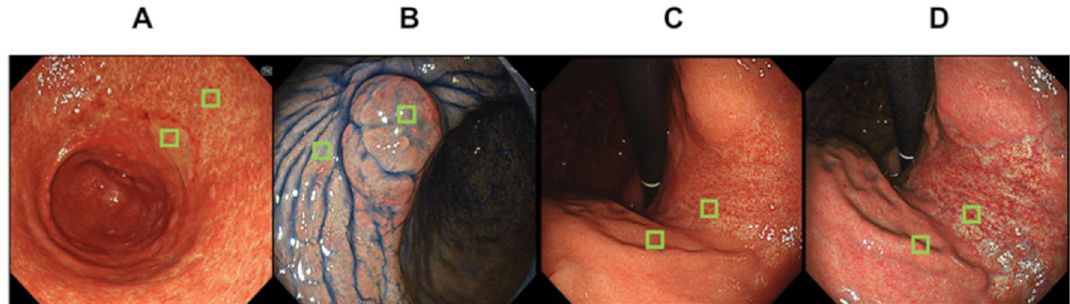
Figure 4. Examples of color sampling in the calculation of color difference: Color was sampled from atrophied and nonatrophied mucosae in atrophy determination. Similar colors were sampled from gastric neoplasms and non-neoplastic areas, and hue differences were calculated in the CIELAB color space system using Adobe Photoshop. ( A ) The area where color sampling is performed from the neoplasm and nearby non-neoplastic areas in the images taken in TXI mode 2. ( B ) The area where sampling is performed from the neoplasm and nearby non-neoplastic areas in the images taken in TXI mode 2 after indigo carmine spraying. ( C ), ( D ) Areas of color sampling in mucosal atrophic and nonatrophic areas taken using WLI and TXI mode 1, respectively.